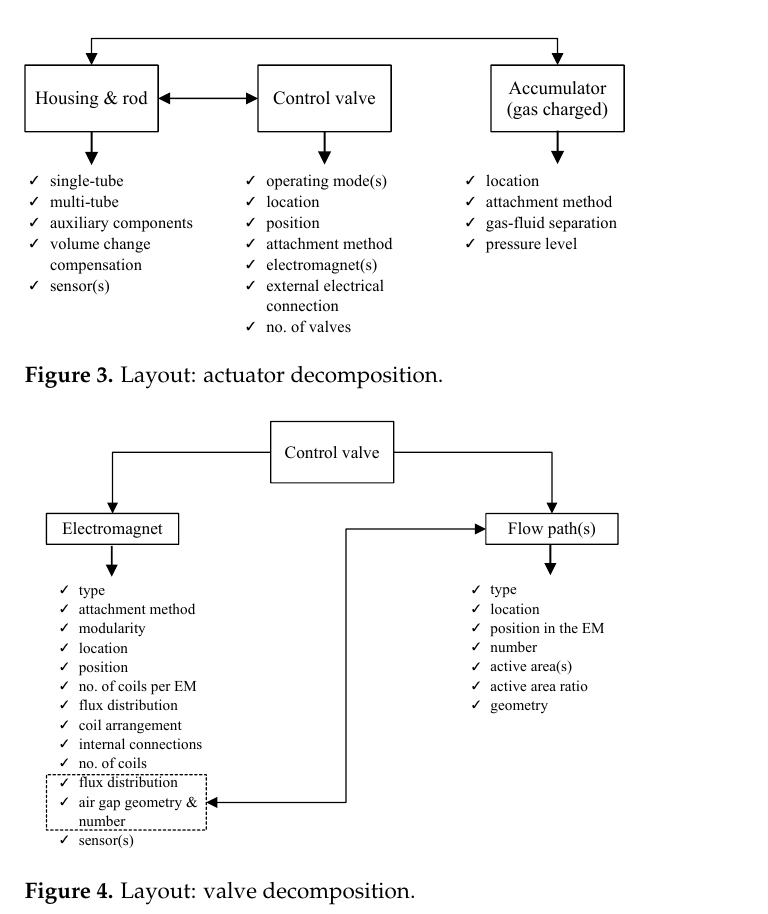
Figure 4. Layout: valve decomposition.